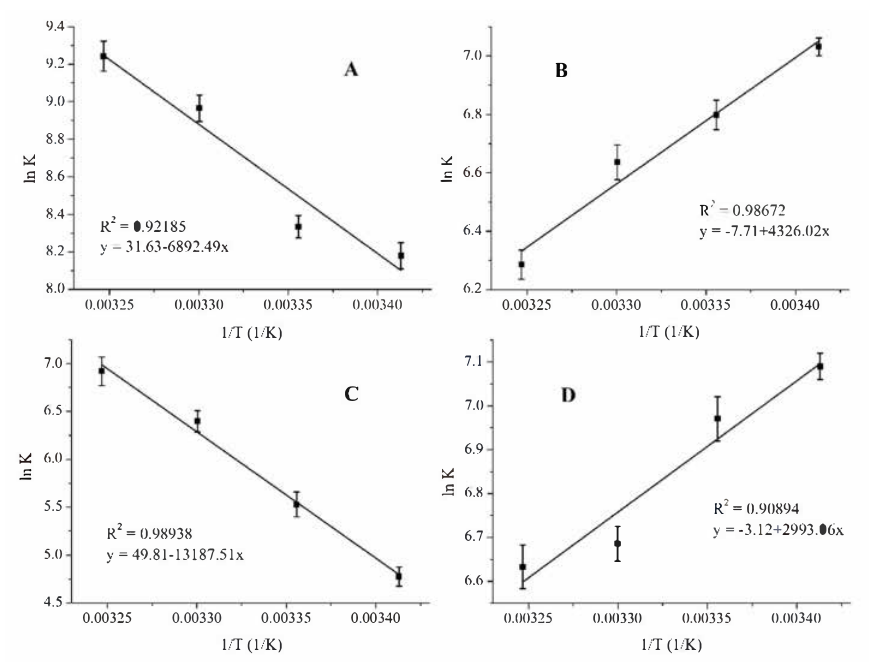
Figure 5. Van ‘t Hoff plots of the complex formation of trans -PHX and TAC ( A ), trans -PHX and TDC ( B ), cis -PHX and TAC ( C ) and cis -PHX and TDC ( D